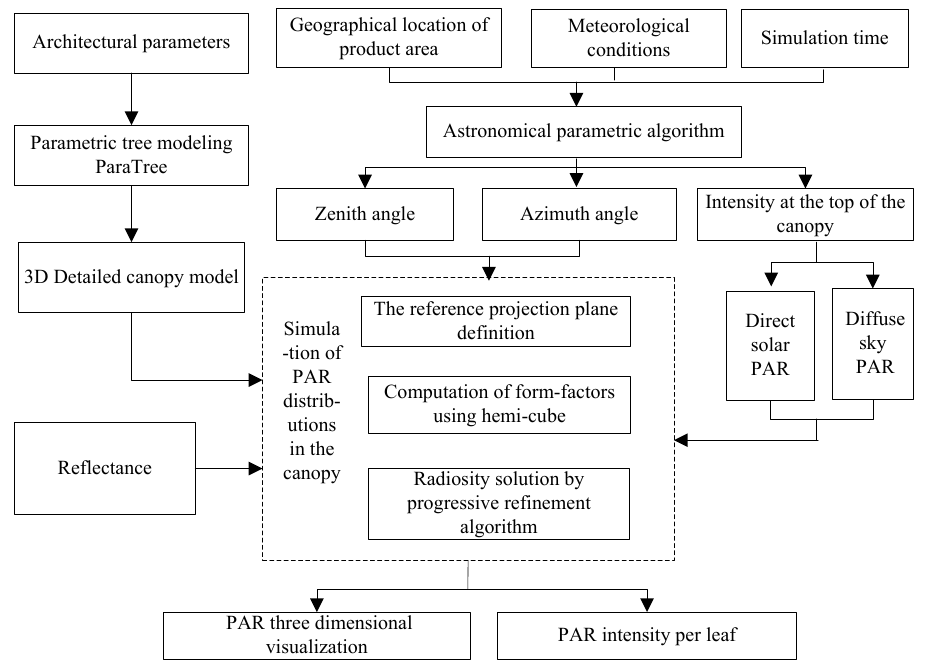
Figure 3. A schematic of the processing pipeline for a light distribution simulation in a canopy.